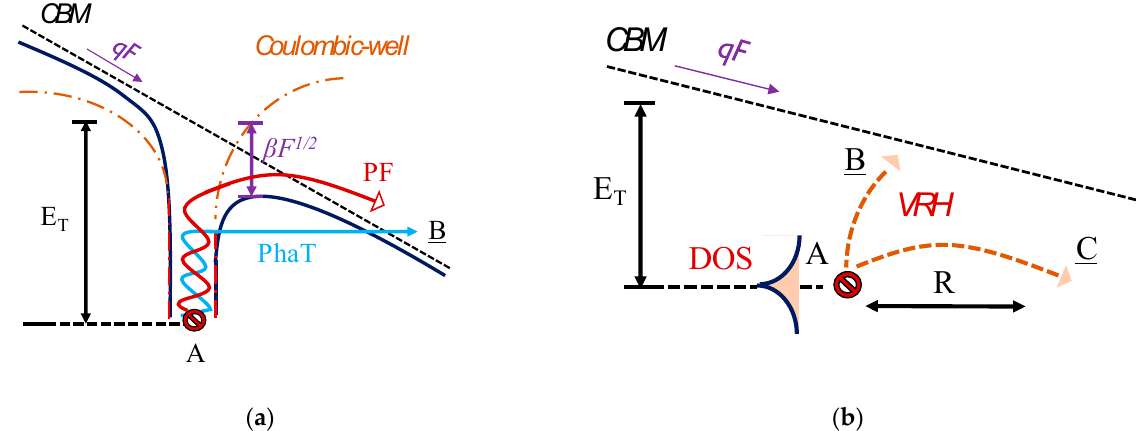
Figure 4. Schematic representation of the leakage processes: ( a ) Poole–Frenkel (PF) emission (used to model Region 1 in Figure 2); ( b ) variable range hopping (used to model Region 2 in Figure 2).